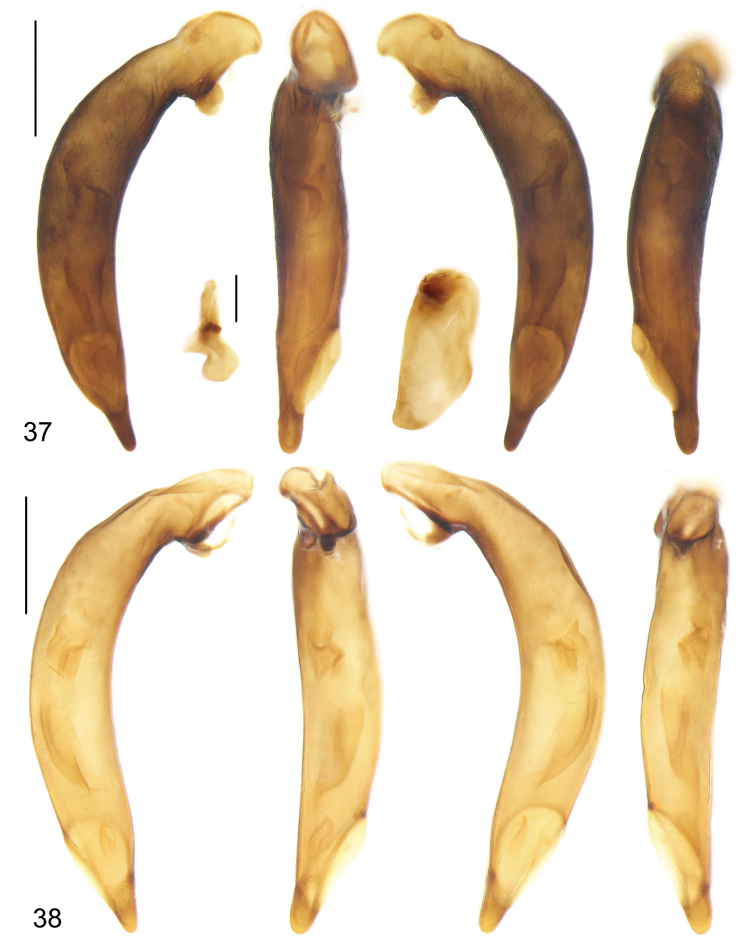
Aedegus: right-lateral, ventral, left-lateral, and dorsal views of median lobe, scale bars 0.5 mm. Right and left parameres, scale bar 0.2 mm. 37
P.
acutidens sp. n. Holotype, Yunnan (Longchuan) 38
P.
ornatus
ornatus Schmidt-Göbel, Yunnan (Mengla).